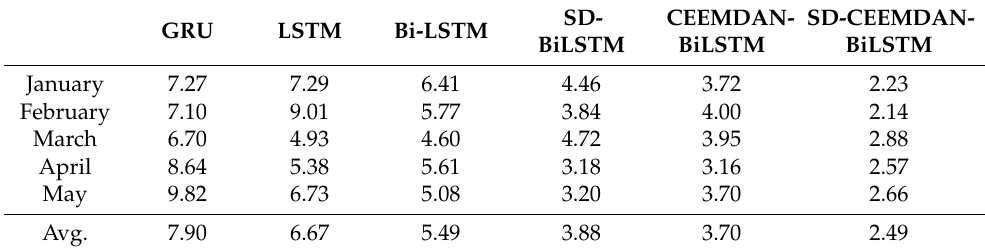
Table 4. MAPE (%) of all the models per month for the three-day-ahead prediction. GRU LSTM Bi-LSTM